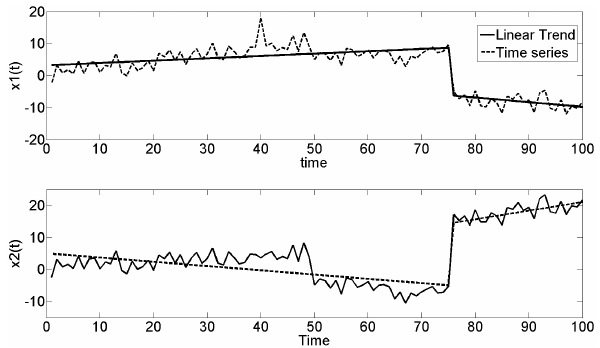
Figure 7. Time series at one station and its clusters/trends are shown. Thin lines show deseasonalized temperature time series and thick lines are linear trends found by the FEM algorithm. All 249 dimensions of the time series are analyzed at the same time, but the figure only shows the result at one of these stations. Table 2. By increasing δ , clusters will become more metastable and the number of transitions between the clusters will be decreased. In fact, the observed process will stay for longer and longer times in the identified metastable cluster before making a transition to the next identified cluster. Regularization factor